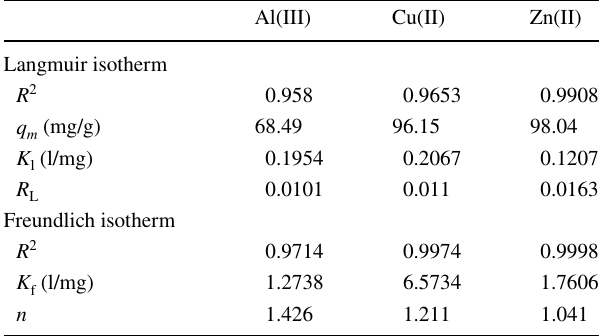
Table 4 Isotherm constants for the adsorption of Al(III), Cu(II) and Zn(II) on MZNCs at pH = 5 for (Al), pH = 6 for (Cu and Zn) and 27 °C